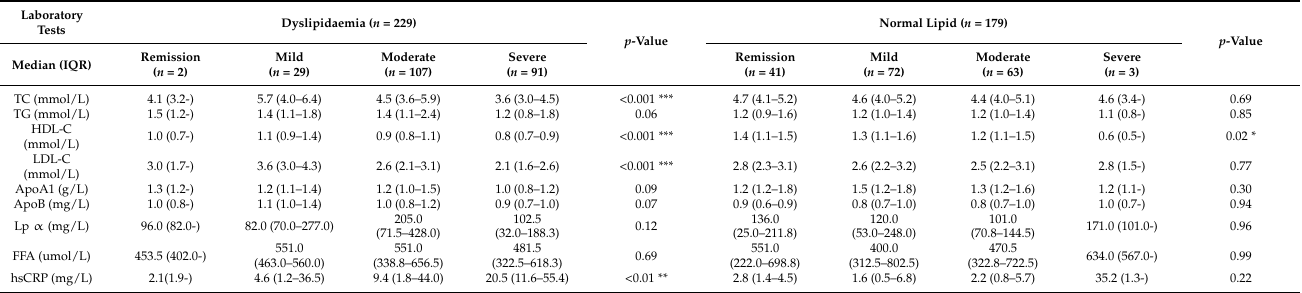
Table 2. Comparison of lipid profiles between different groups of disease activity based on MS in patients with dyslipidaemia and normal lipid